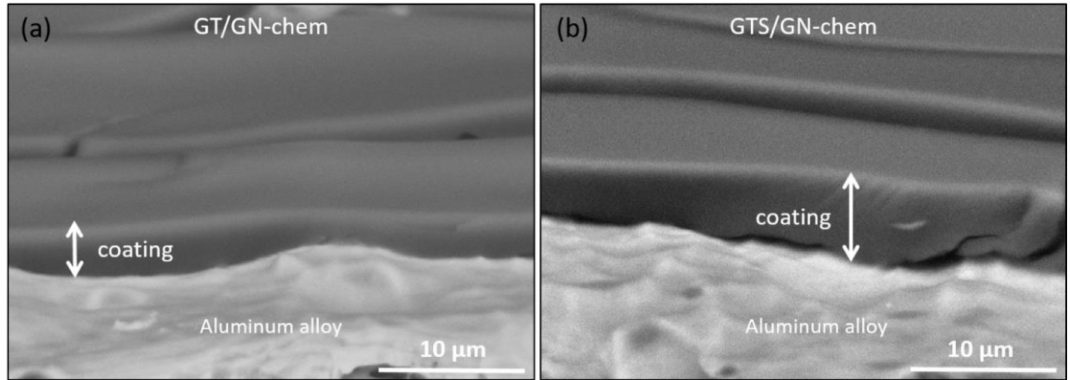
Figure 3. SEM images of cross sections of GT / GN-chem ( a ) and GTS / GN-chem coatings ( b ) on AA2024 alloy.